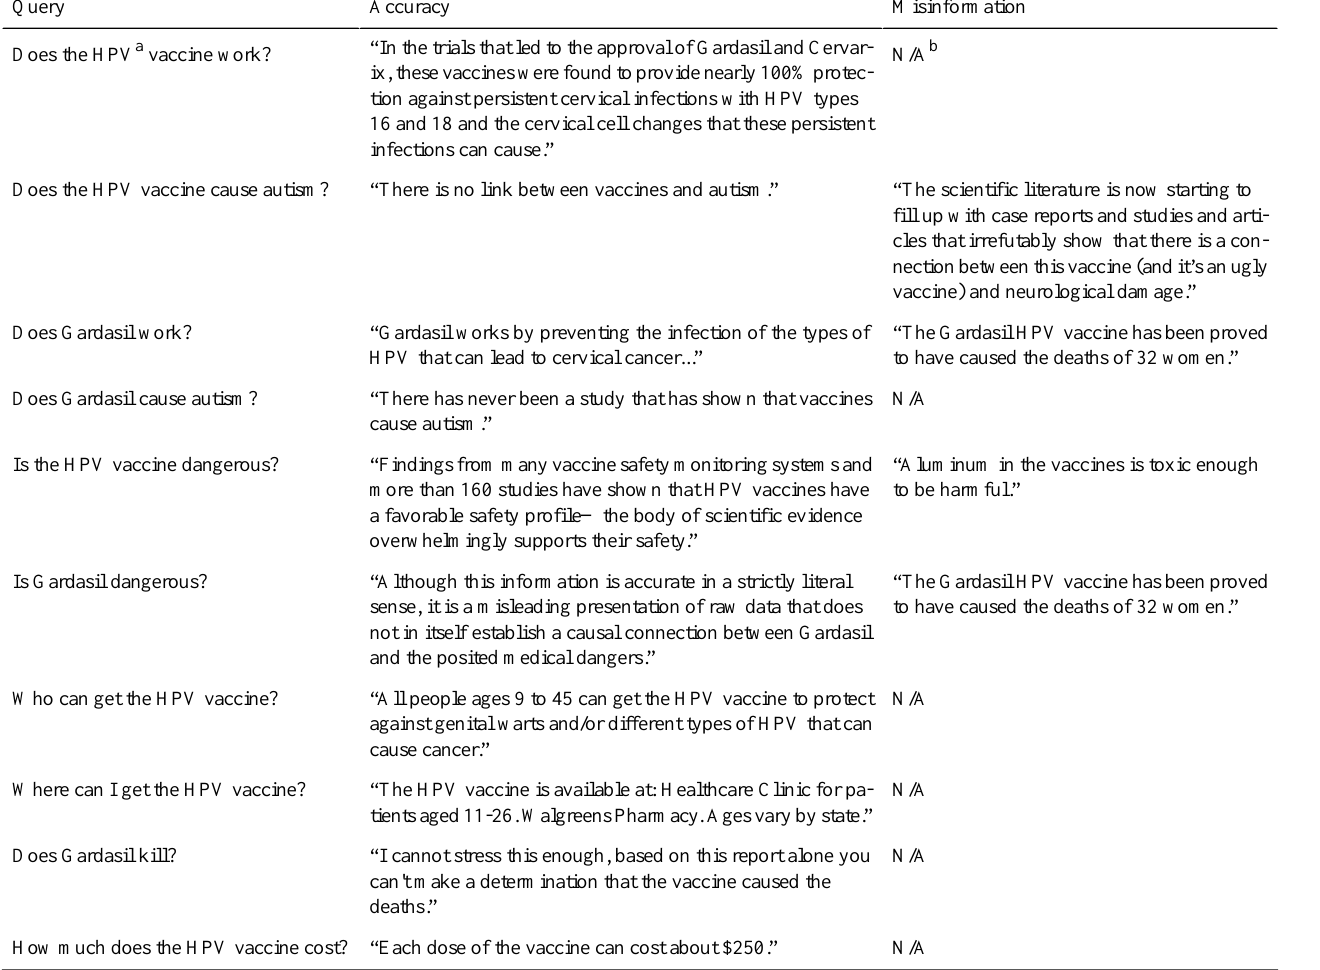
Table 1. Examples of accuracy and misinformation in smart assistant responses.